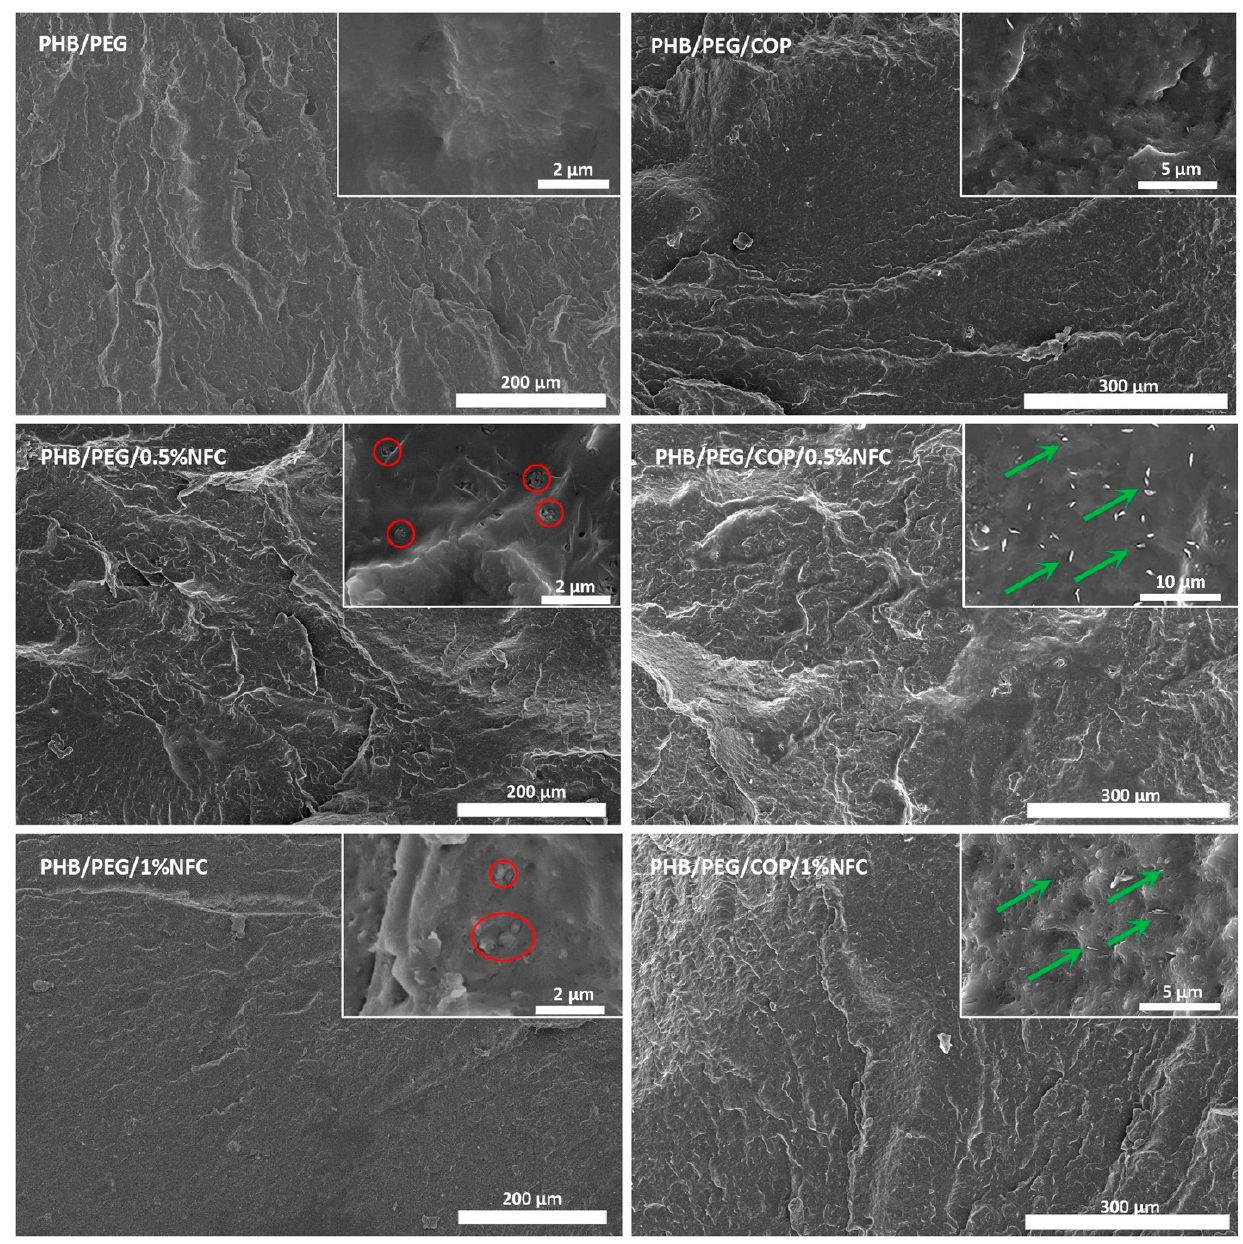
Figure 2. FESEM micrographs (secondary electrons) showing the cross-sections of the two references, PHB/PEG and PHB/PEG/COP, and the related composites with 0.5% and 1% of NFCs, specifically PHB/PEG/0.5%NFC, PHB/PEG/1%NFC, PHB/PEG/COP/0.5%NFC, and PHB/PEG/COP/1%NFC. The insets present higher-magnification images. (Red circles and green arrows highlight NFC aggregates and better exfoliated NFC fibrils, respectively).